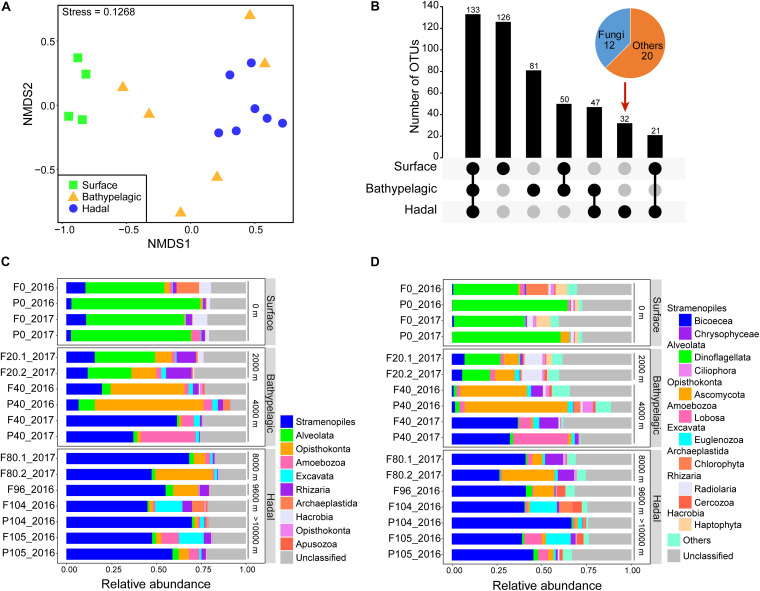
Community characteristics of microbial eukaryotes in the Mariana Trench. (A) Comparison of community structure based on a non-metric multidimensional scaling analysis (NMDS). Samples were grouped according to three layers: surface, bathypelagic, and hadal layers. (B) Core and differential operational taxonomic units (OTUs) among the surface, bathypelagic, and hadal layers. Layers included in a set were represented by filled dots in the matrix below each bar. Community composition of microbial eukaryotes from the surface to the bottom of the Mariana Trench at superphylum (C) and phylum/class levels (D).